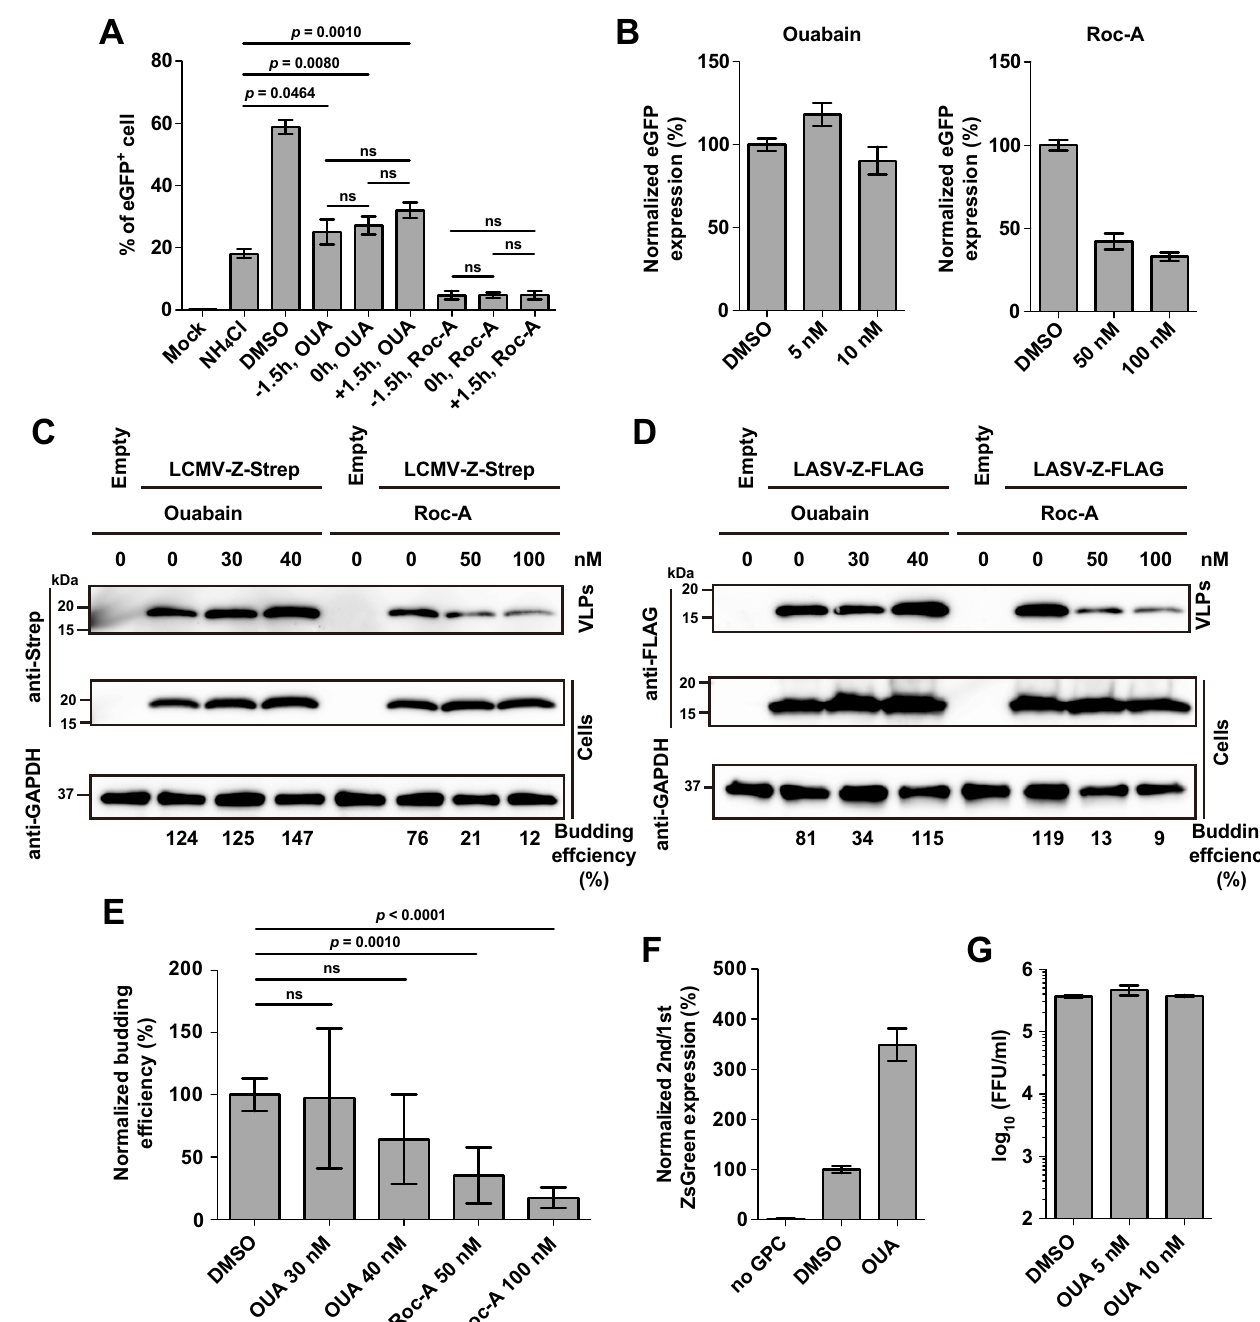
Fig 6. ATP1A1 and PHB are involved in different steps of the mammarenavirus life cycle. (A) Influence of time of addition of ouabain (OUA) or rocaglamide (Roc-A) on virus multiplication. A549 cells seeded (2.5 x 10 5 cells/well) in a 12-well plate and cultured overnight were infected (moi = 0.1) with rLCMV/eGFP or remained uninfected (mock). OUA (10 nM), Roc-A (100 nM), or DMSO (0.01%) was added to the culture media at the indicated time points and remained present throughout the end of the experiment. Ammonium chloride (20 mM) was added to culture medium at 4 h pi to prevent multiple rounds of virus infection. At 24 h pi, eGFP expression in infected cells was examined by flow cytometry. Data represent mean ± SD of the results of three independent experiments. (B) Effect of ouabain and Roc-A on LCMV replication. A549 cells seeded (1.25 x 10 5 cells/well) in 24-well plates and cultured overnight were infected (MOI = 1) with rLCMV Δ GPC/eGFP, followed by addition of the indicated concentrations of ouabain or Roc-A. At 72 h pi, total cell lysates were prepared, and eGFP expression levels were measured using a fluorescent plate reader. Data represent mean ± SD of three independent experiments. (C-E) Effect of ouabain and Roc-A on Z-mediated budding. Cells (HEK 293T) seeded (3.5 x 10 5 cells/well) in a 12-well plate and cultured overnight were transfected with 0.5 μg of either pC-Empty or pC-LCMV-Z-Strep (LCMV-Z-Strep) (C) or pC-LASV-Z-FLAG (LASV-Z-FLAG) (D, E) . At 24